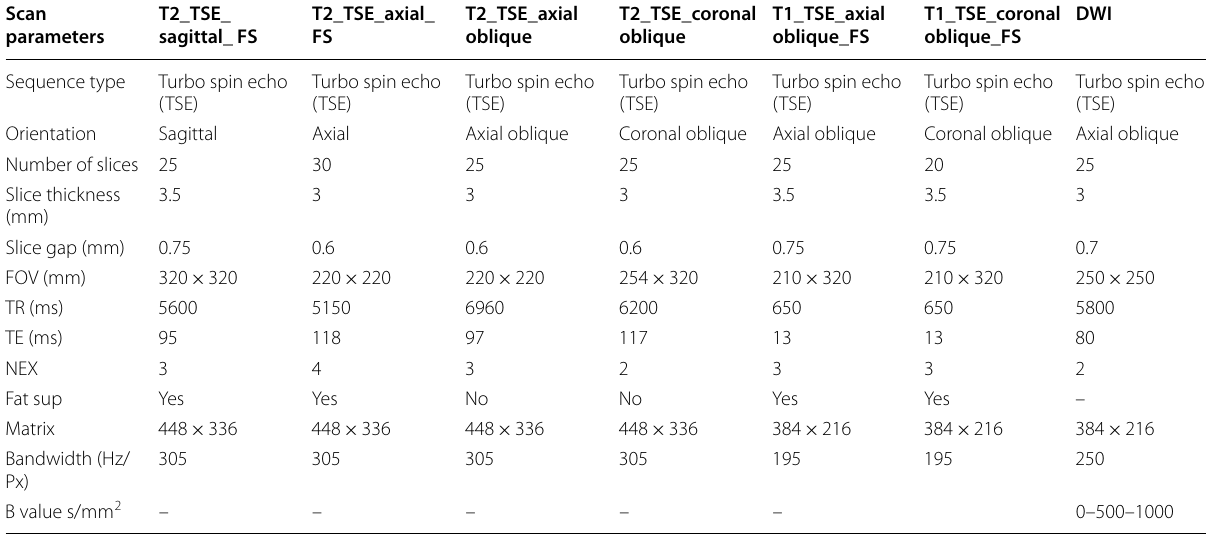
Table 2 Protocol and applied sequence parameter in 2 nd institution with the 1.5 Tesla system (Magnetom Sempra, Germany) Scan